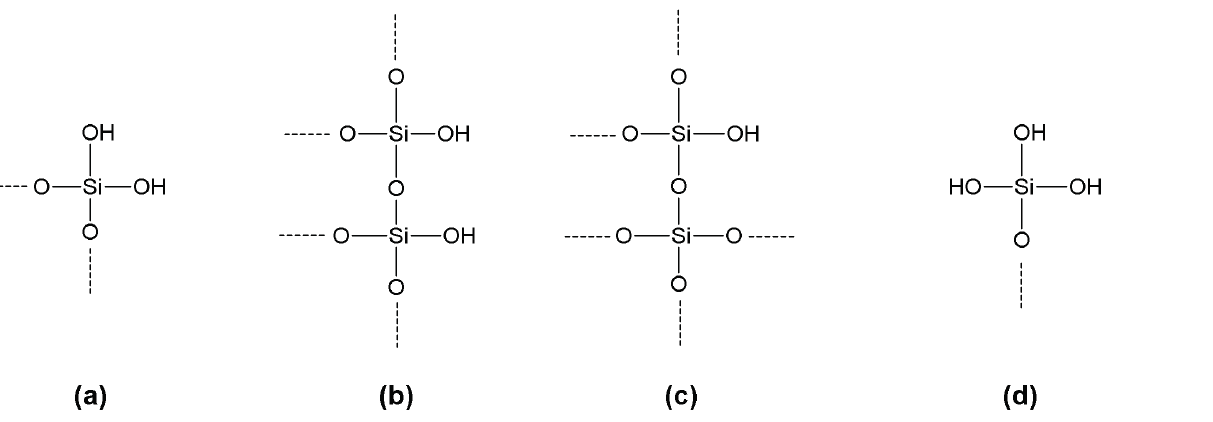
Figure 2. Several types of silanol functions can be found on the surfaces of silica-based materials: geminal silanols ( a ), vicinal silanols ( b ), isolated silanols ( c ). Silanetriols ( d ) have never been found on silica